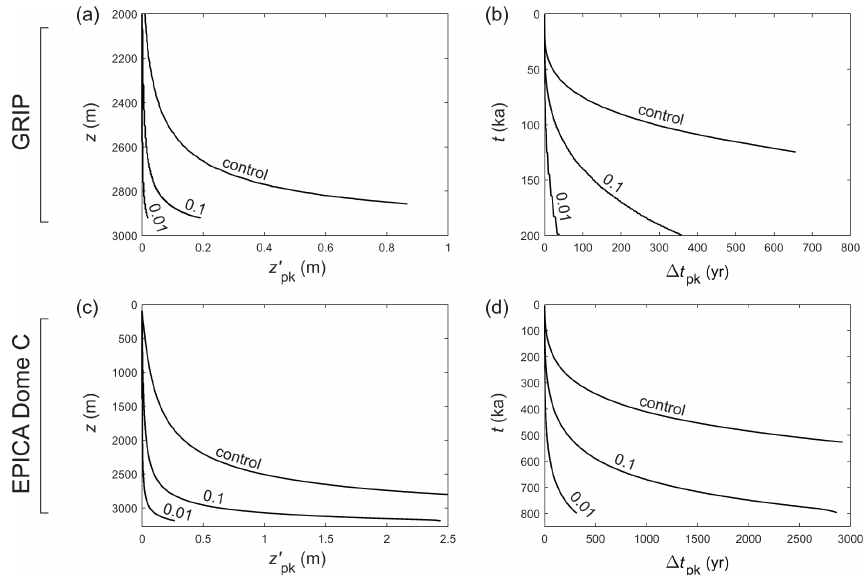
Figure 9. Modelled displacement z (cid:48) pk and age offset (cid:49)t pk of signal peaks (from ice of the same age) at the (a, b) GRIP and (c, d) EPICA core sites for different parameters, plotted against depth and age of the ice. “Control” labels the control runs in Figs. 5a and 6a; 0.1 and 0.01 label those runs in Figs. 7 and 8 where the molecular diffusivity D is suppressed by these factors to simulate vein blockage. The control curve in panel (a) is equivalent to the curve in Fig. 4 of Rempel et al. (2001), except these authors assumed a different age–depth scale from